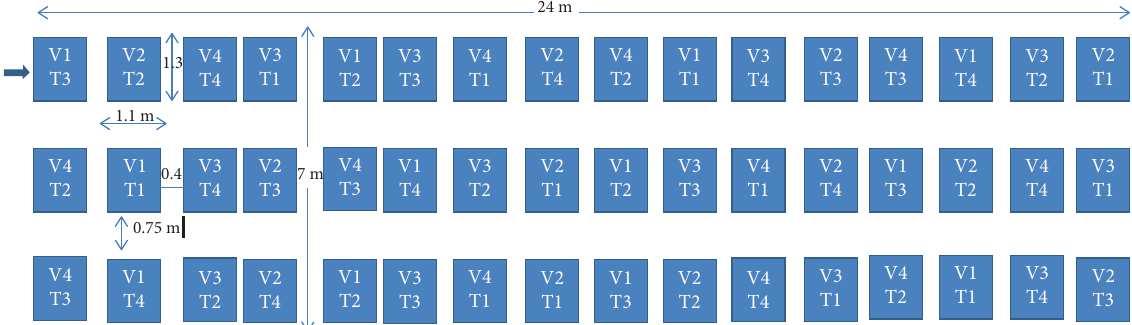
Figure 2: Layout of feld